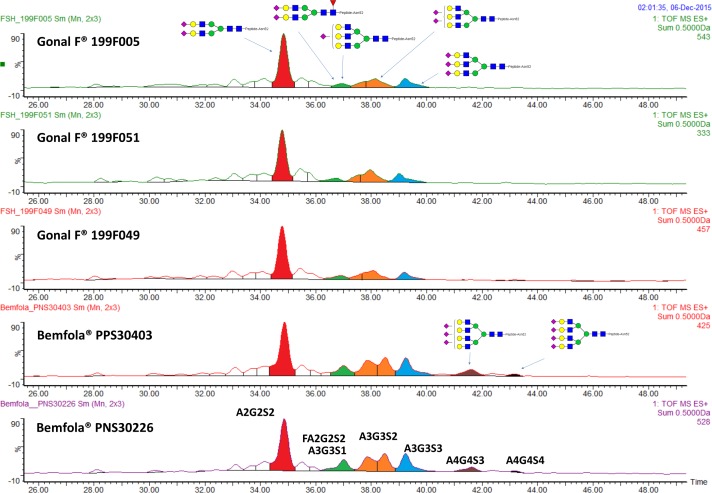
Extracted ion chromatograms of the N-glycan distribution at Asn52 for Bemfola and GONAL-f.Fig was constructed using MassLynx 4.1 (Waters, Milford MA, USA) from the respective XIC of the glycopeptides extracted from only Asn52. Asn, asparagine. Blue square, GlcNAc. Green circle, mannose. Yellow circle, galactose. Red triangle. fucose. Purple diamond, sialic acid NeuNAc. Glycan naming: F at the start of the abbreviation indicates a core a(1–6) fucose linked to the inner GlcNAc. Ax indicates the number of antenna (GlcNAc) on trimannosyl core. A2 indicates bi-antennary with both GlcNAcs as b(1–2) linked. A3 indicates tri-antennary with a GlcNAc linked b1-2 to both mannose and a third GlcNAc linked b(1–4) to the a(1–3) linked mannose. A4 indicates tetra-antennary with GlcNAcs linked as A3 with additional GlcNAc b(1–6) linked to a(1–6) mannose. Gx indicates the number (x) of b1-4 linked galactose on the antenna. Sx indicates the number (x) of sialic acids linked to galactose.